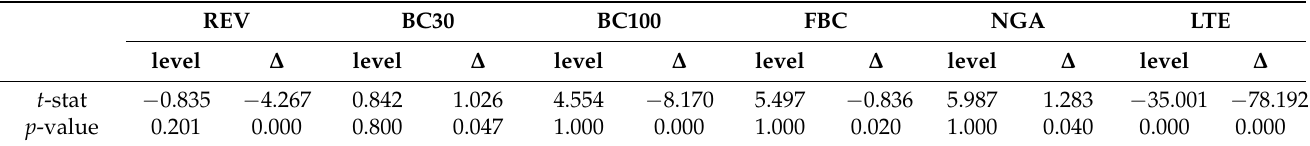
Table 4. Unit root Table 4. Unit root test — LLC.